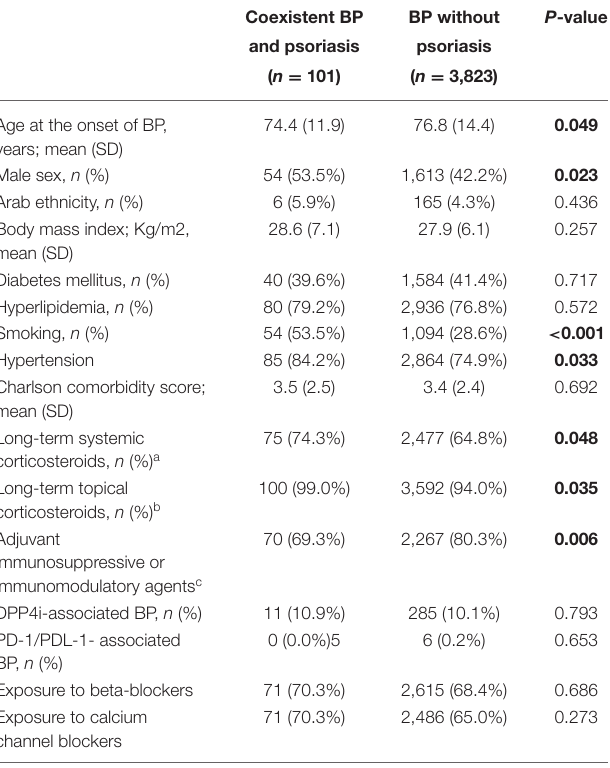
TABLE 5 | Comparison between patients with coexistent bullous pemphigoid and psoriasis relative to the remaining patients with bullous pemphigoid. Coexistent BP BP without P -value and psoriasis